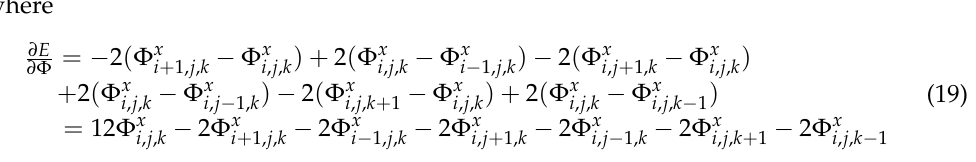
where µ R and µ T are means of V R and V T and where σ R and σ T are standard deviations of V R and V T . Mutual information (MI) was defined as